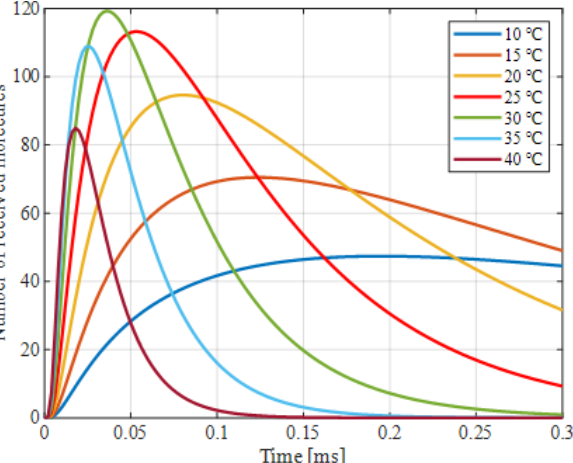
Figure 8. Number of received molecules in consideration of temperature changes.